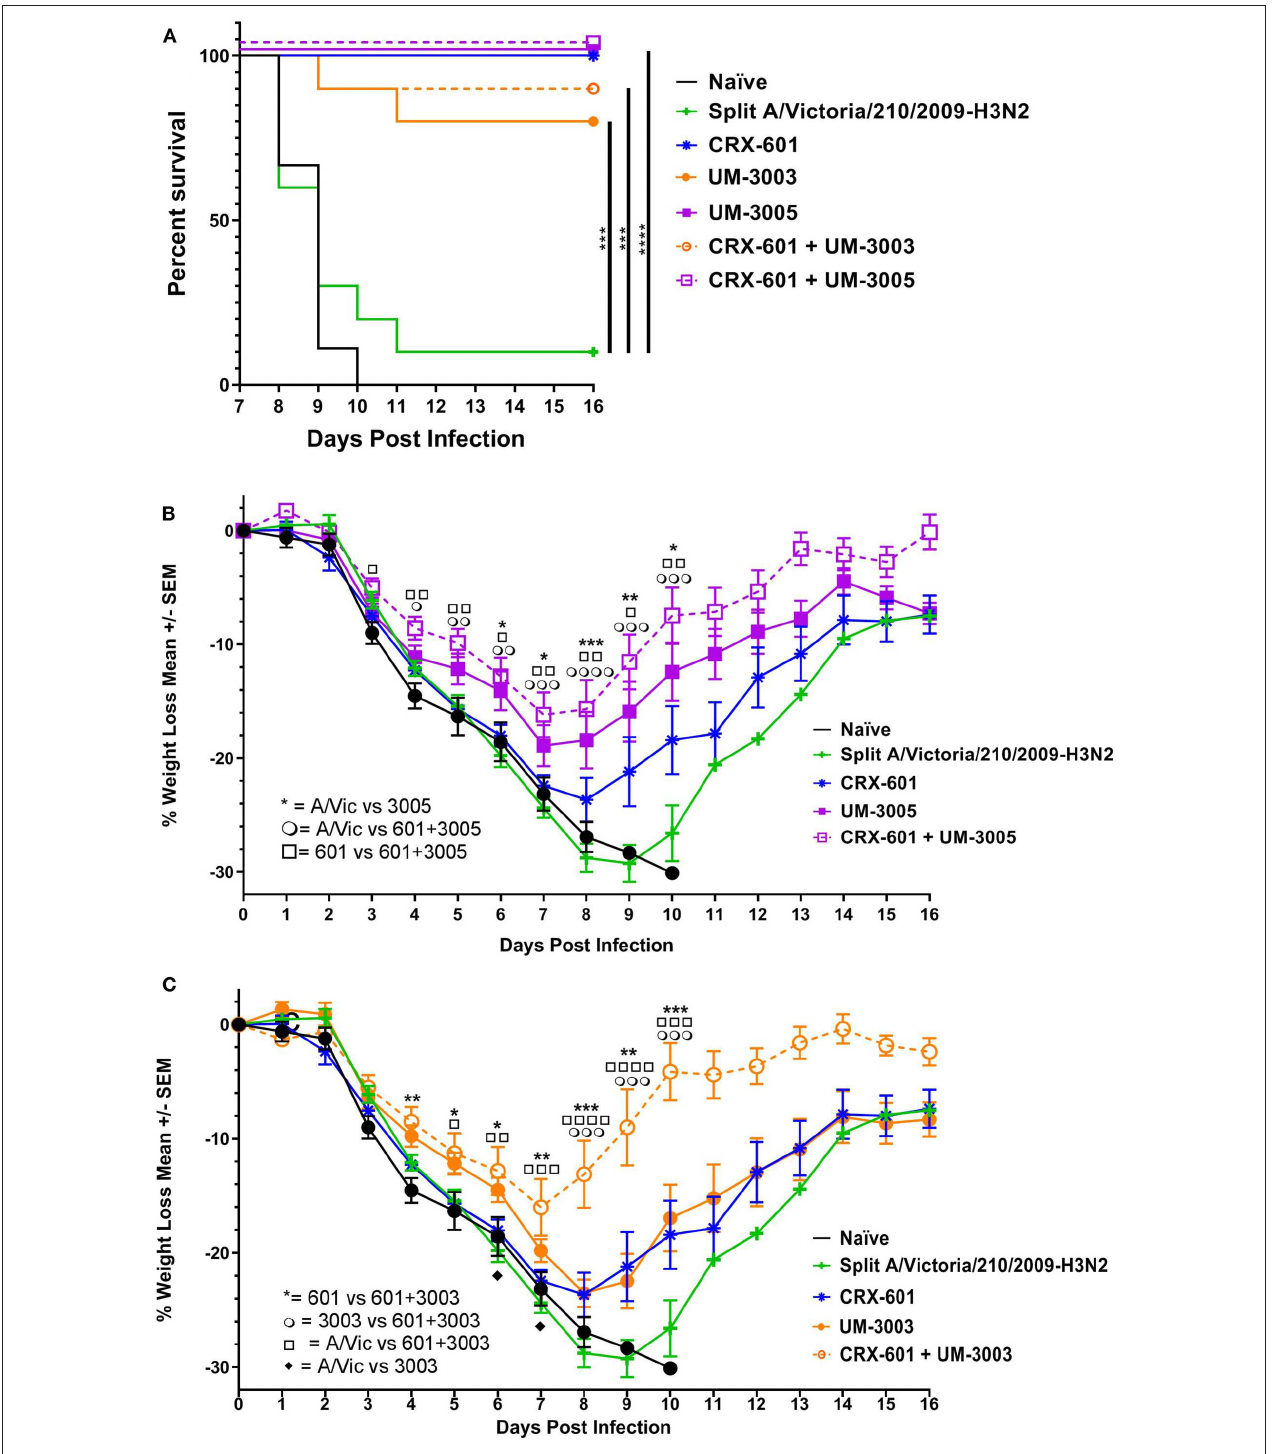
FIGURE 5 | Lipidated imidazoquinolines with or without a TLR4 agonist protect against lethal, heterologous H3N2 challenge. Balb/c mice were immunized i.m. twice, 14 days apart, with A/Vic monovalent detergent-split influenza vaccine (0.3 µ g/mouse) adjuvanted with indicated TLR4 (0.1 µ g/mouse), TLR7/8 (10 µ g/mouse), or TLR4 + TLR7/8 agonists. Three weeks after the second immunization, 10 mice per group were challenged i.n. with 3LD50 HK68 (H3N2) mouse-adapted influenza virus. Mice were monitored daily for weight loss, temperature, and body condition. (A) Percent of surviving mice in each group. (B,C) Average